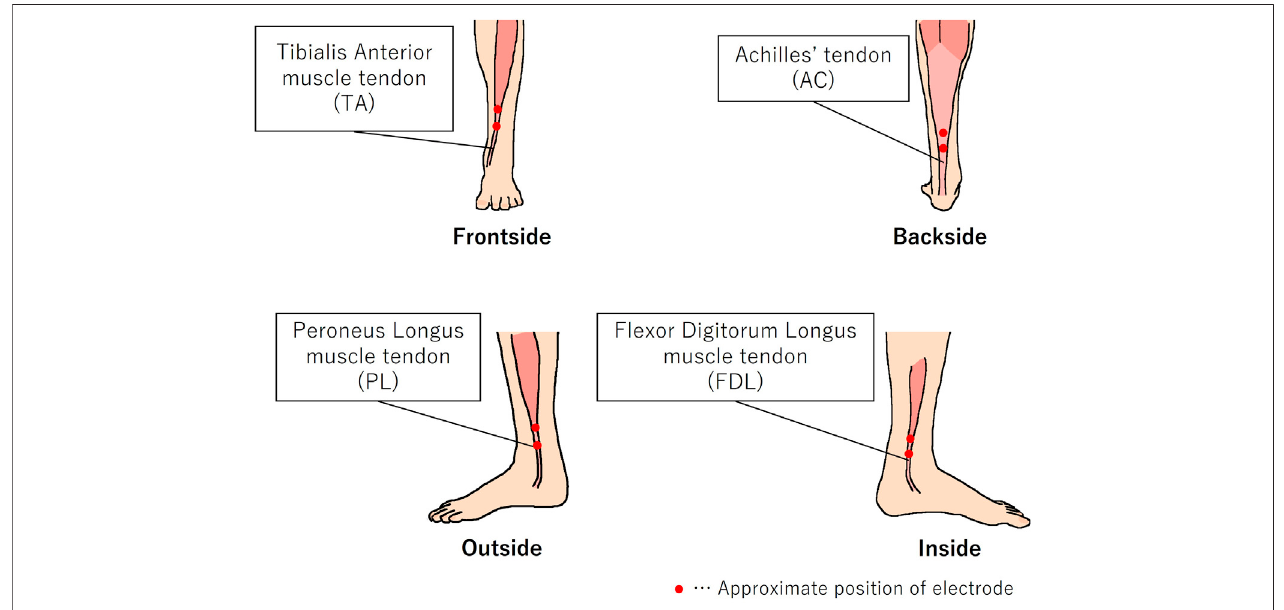
FIGURE 1 | Anatomical positions of the targeted tendons in the left leg. The red dots show the approximate positions of the electrodes placed for electrical stimulation.